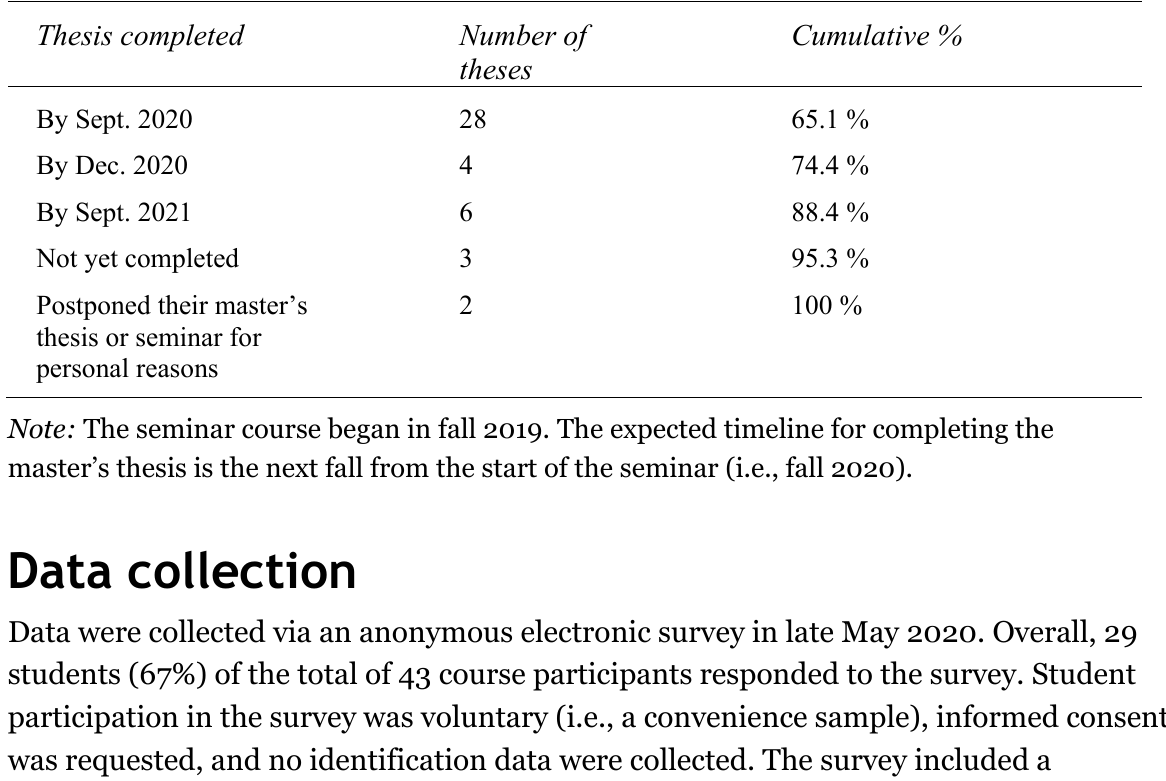
Table 2 Completion of master’s